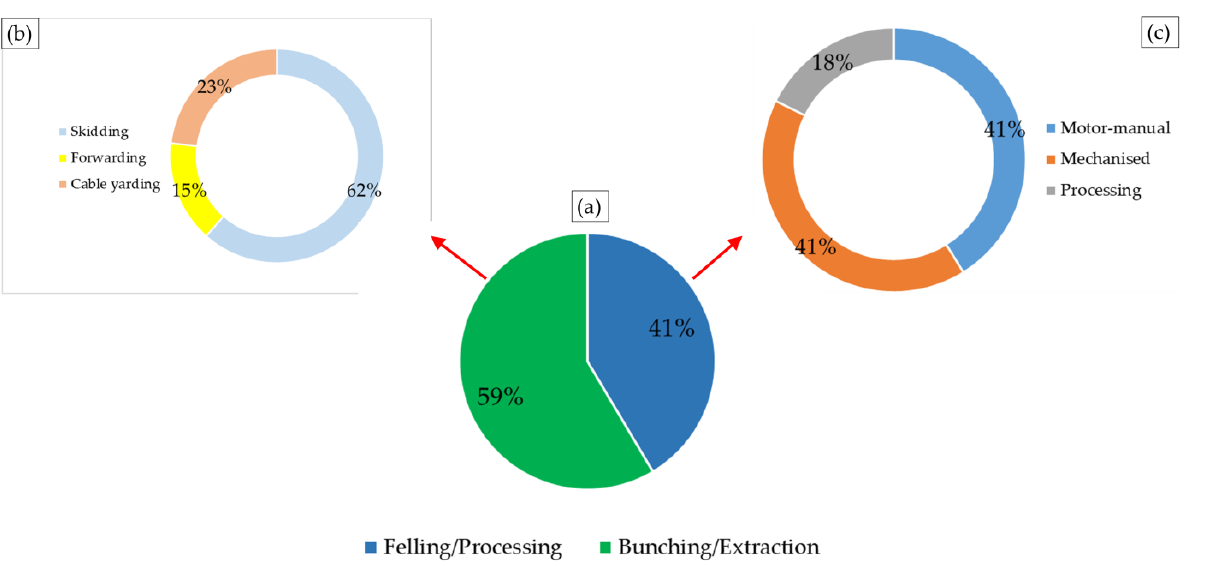
Figure 1. Summary of forest operations in beech forests from the investigated literature. ( a ) Percentage share of the investigated studies between studies dealing with felling-processing and bunching-extraction. ( b ) Percentage share of studies dealing with bunching-extraction, i.e., studies dealing with skidding, forwarding and cable yarding operation. ( c ) Percentage share of studies dealing with felling-processing, i.e., studies dealing with motor-manual felling-processing operations, mechanised felling-processing operations and processing operations at the landing site.